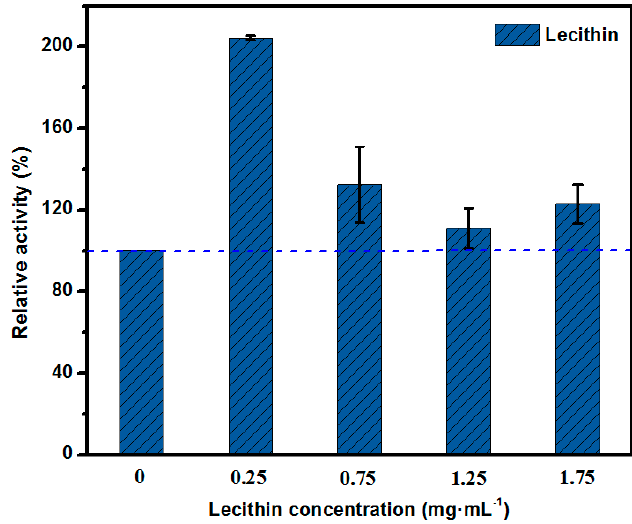
Figure 2. The effect of the concentration of lecithin on the relative activity of free lipase.